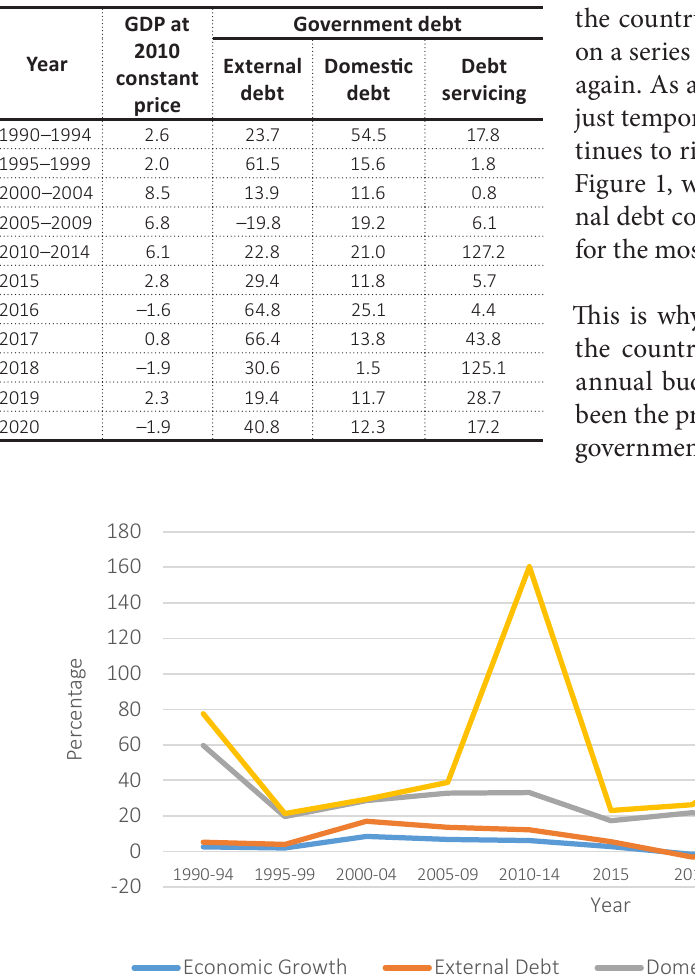
Figure 1. Trend of economic growth and government debt in